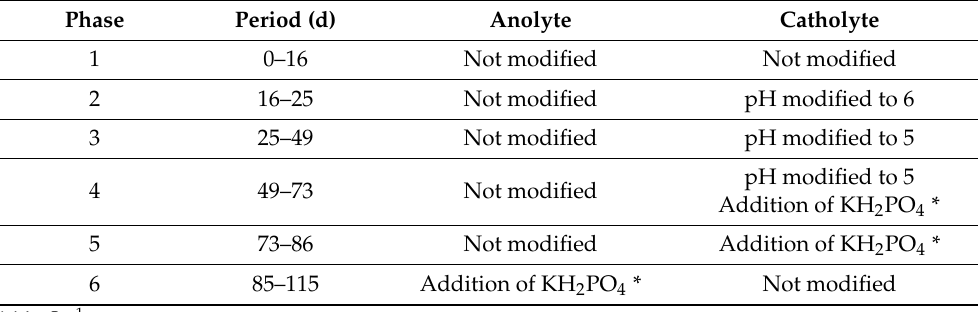
Table 2. Operational phases of the MEC and modification of the anolyte or catholyte, regarding the pH value or phosphate